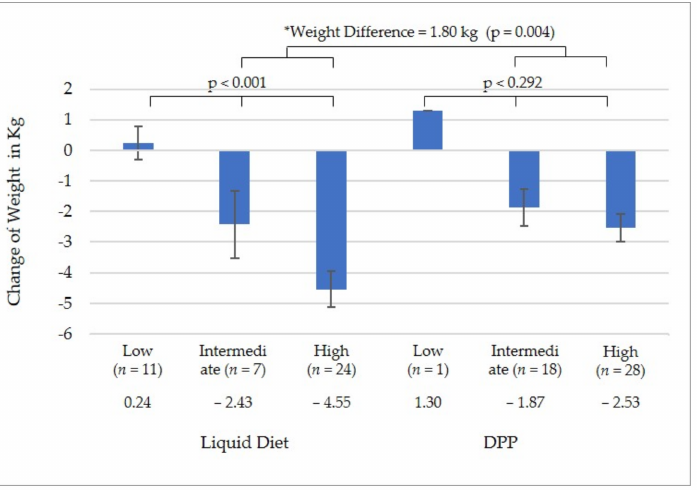
Figure 4. Change in weight by level of attendance. * Weight difference between groups excluding the participants with low